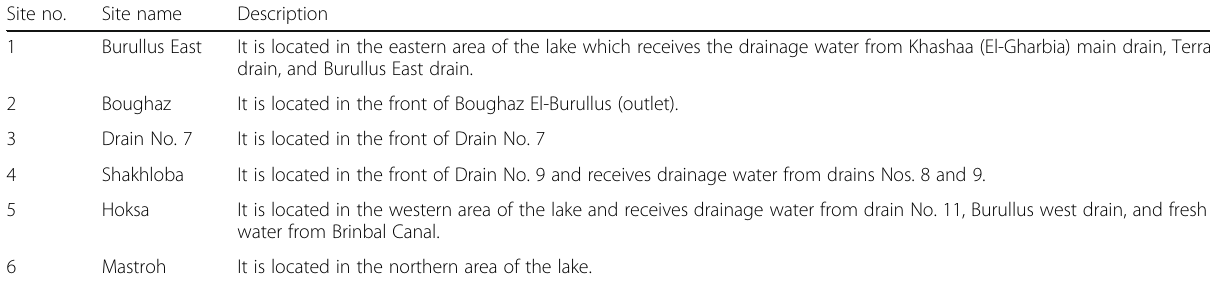
Table 1 The description of sampling sites in Burullus Lake Site